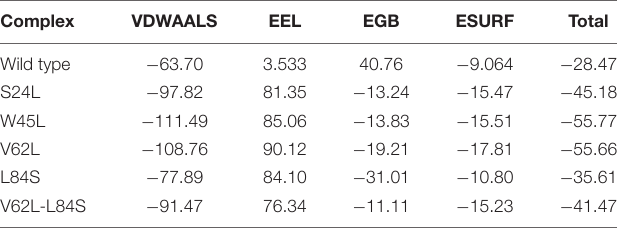
TABLE 1 | MM/GBSA binding free energies of the ORF8 WT and ORF mutants.